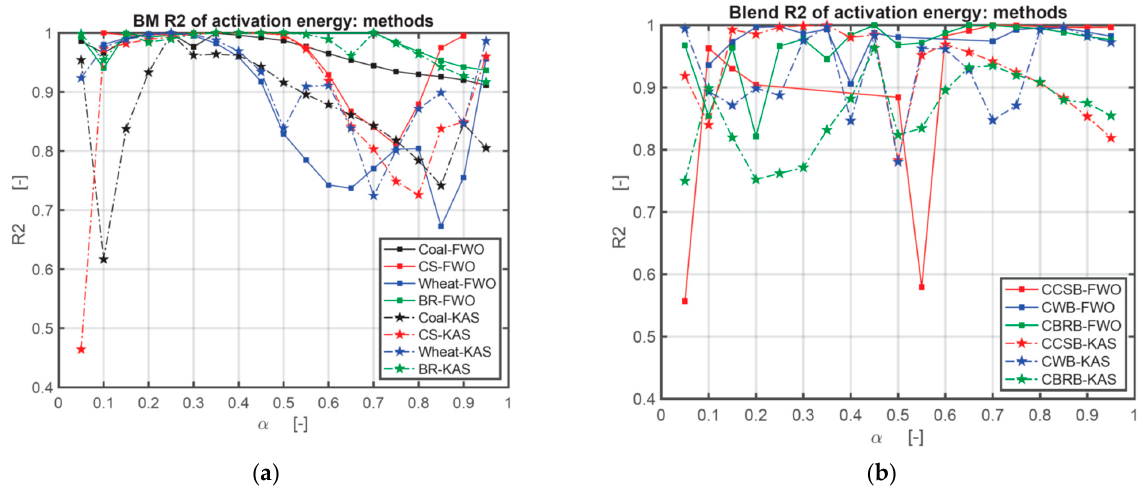
Figure 5. Comparison of correlation coefficient ( R 2 ) obtained with FWO and KAS methods: ( a ) comparison of correlation coefficient ( R 2 ) of coal and BM obtained with FWO and KAS methods; ( b ) comparison of correlation coefficient ( R 2 ) of CBB obtained with FWO and KAS methods.